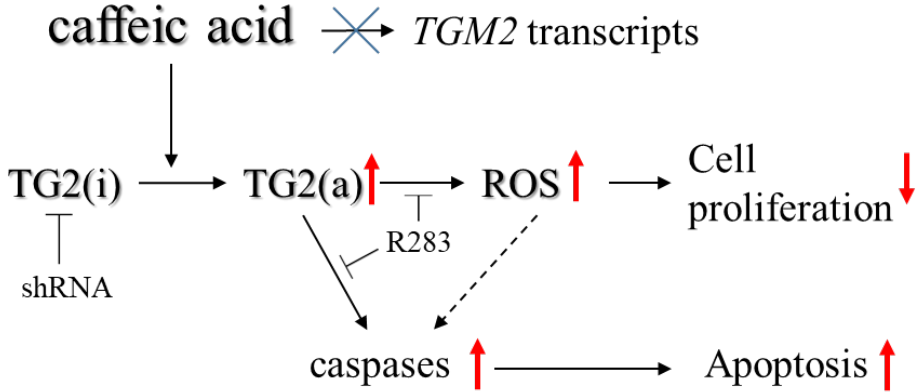
Figure 6. Schematic summary of the effects of CA on cell proliferation and apoptosis in CML cells. TG2 (i) = TG2 inactive; TG2 (a) = TG2 active. Red arrows: modulatory effect of CA-treatment. Treat- ment with CA does not modify the transcription of the TGM2 gene but increases the level of active TG2 by triggering the conversion of the inactive form into the active one. TG2 activity increases the way leading to cell death by